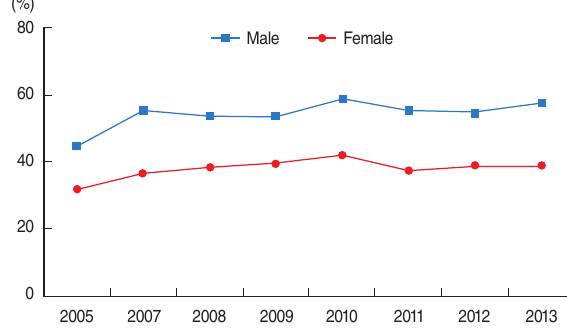
Figure 3. Trends in prevalence of secondhand smoke exposure in workplace 1 in the Korea National Health and Nutrition Examination Survey during 2005 to 2013. Proportions were calculated using the direct standardization method and was based on a 2005 popula- tion projection. 1 Adults (aged 19 years and older; age-standardized): percentage of current non-smokers who were exposed to cigarette smoke in workplace (2013: during the past 7 days).